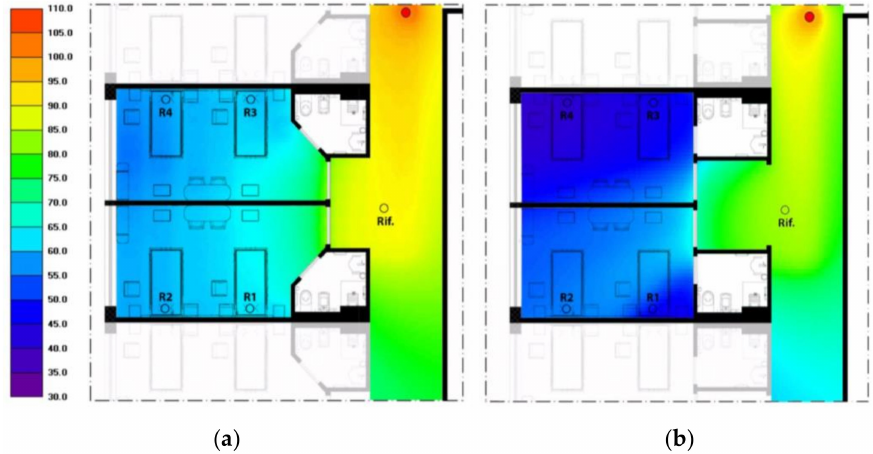
Figure 14. Results of simulations of sound propagation generated by a source in the corridor: on the left, in the original configuration ( a ) and on the right, in the modified configuration ( b ). Adapted with permission from Ref